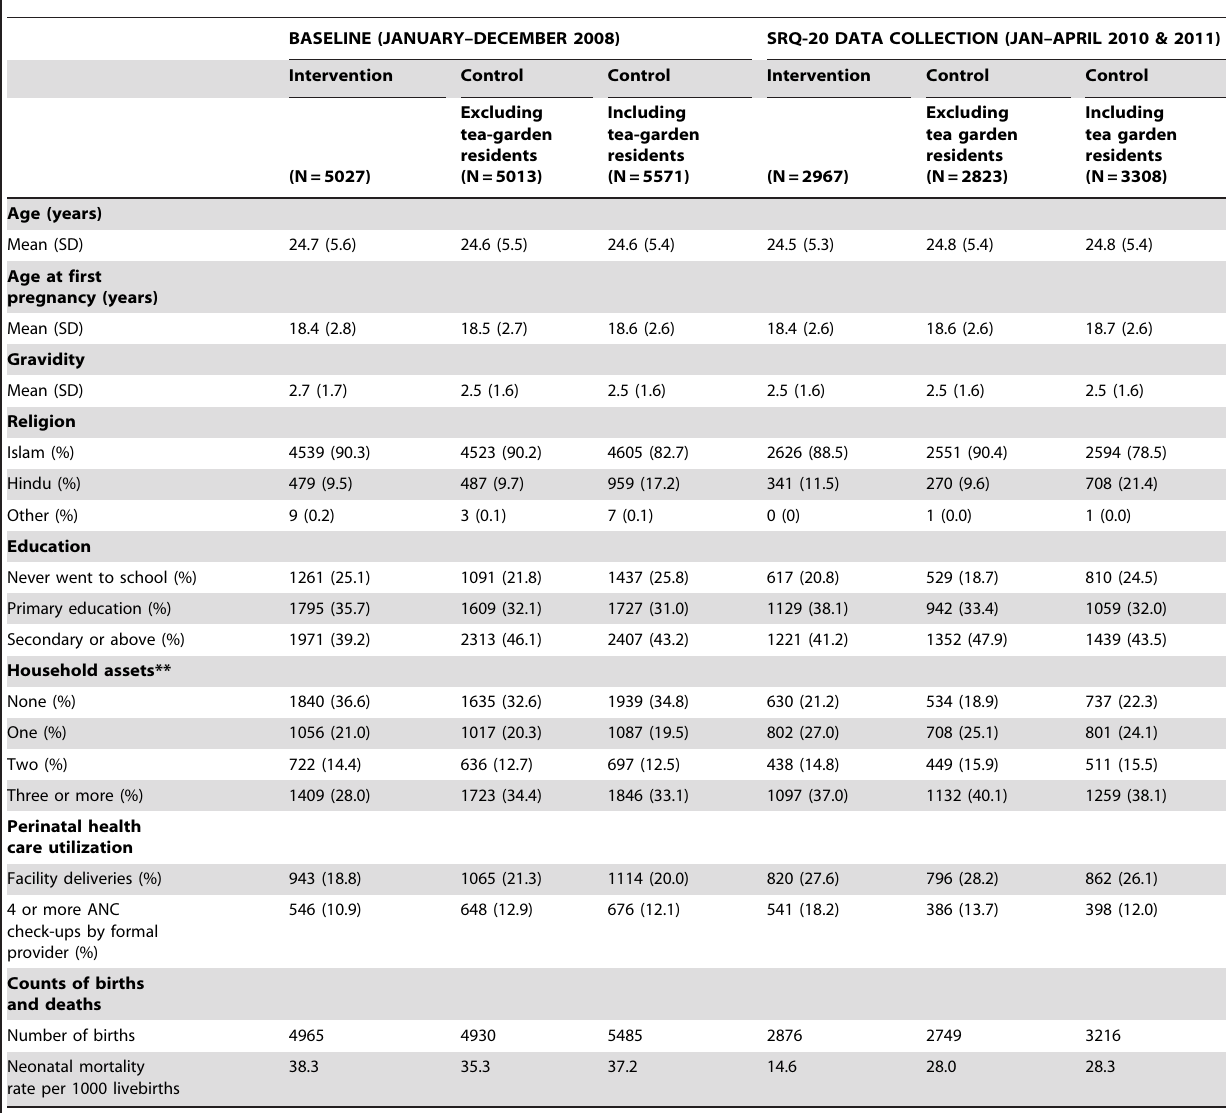
Table 1. Respondent characteristics for intervention and control areas (with and without tea garden residents) at baseline and during the SRQ-20 data collection